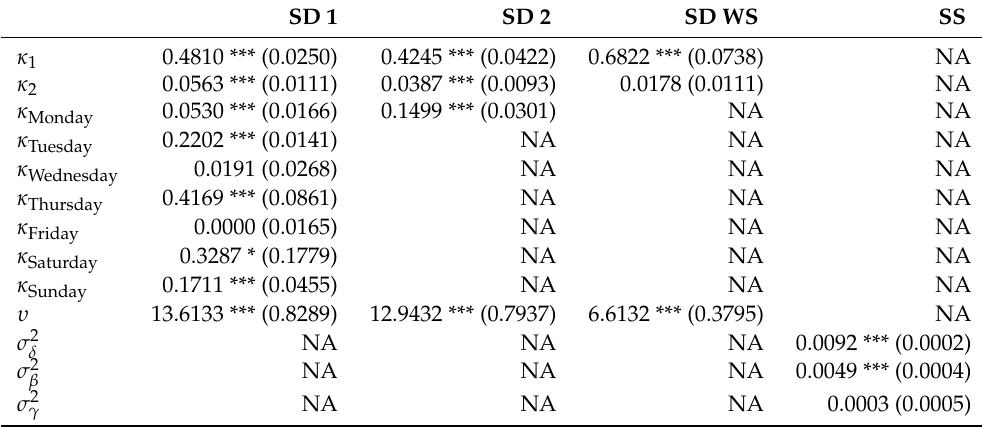
Table A2. Parameter estimates for Argentina.